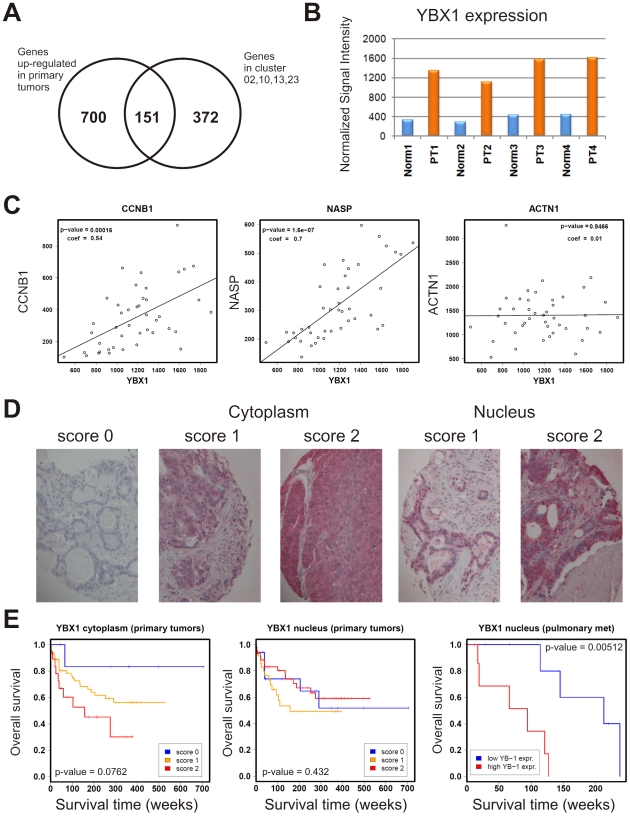
MEK/ERK pathway signature, YBX1 expression, and prognostic value in primary and metastatic colorectal cancer cells.(A) Venn diagram showing the overlap between genes differentially expressed in primary colorectal tumors and MEK/ERK pathway-dependent, proliferation-associated target genes identified in colorectal cancer cell lines treated with the MEK inhibitor U0126. The number of the U0126-responsive genes (523) is smaller than originally identified in the cell lines (776), because there are fewer genes present on the HG-U95A chip compared to the HG-U133A chip. (B) YBX1 expression in matched pairs of colorectal cancers and normal tissues as detected on Affymetrix HG-U95A microarrays. (C) Examples of co-expression of YBX1 and YBX1 targets CCNB1 and NASP (nuclear autoantigenic sperm protein) in a set of 43 primary colorectal tumors as detected on Affymetrix HG-U95A microarrays. Discordant expression of YBX1 and non-target ACTN1 (actinin, alpha 1) shown in the same tumor set. Pearson correlation coefficients (coef) and p-values are inserted in the graphs. Further examples of YBX1 targets are shown in Figure S4. (D) Expression of YBX1 in colorectal tumor sections assembled on tissue microarrays. TMAs were analyzed by immunohistochemical staining using peptide-specific antibodies directed against the N-terminus of YBX1. Cytoplasmic and nuclear staining was scored independently. Score 0, negative for YBX1 expression, score 1, intermediate expression; score 2, high expression. (E) Kaplan-Meier plots showing the association between YBX1 expression and overall patient survival. Left: predominant cytoplasmic YBX1 expression in primary tumors; middle: nuclear YBX1 expression in primary tumors; right: nuclear YBX1 expression in pulmonary metastasis. Clinical data are shown in Table S7.